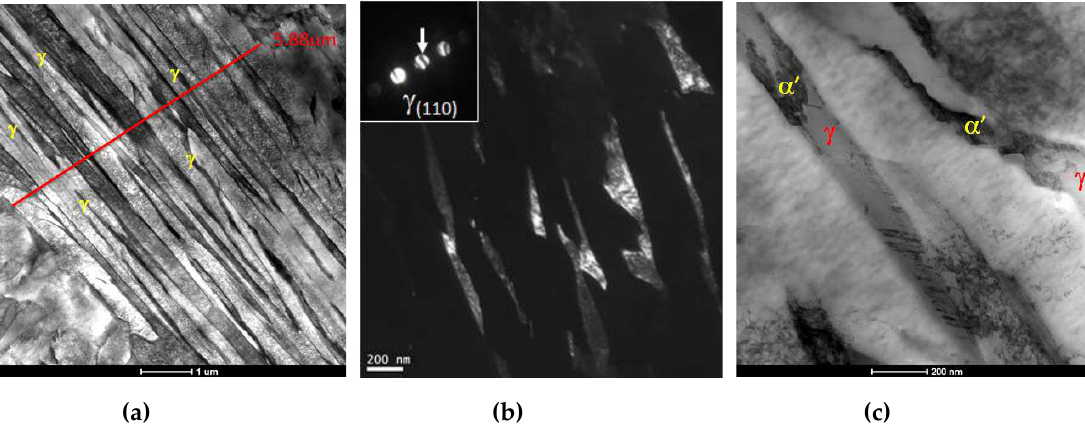
Figure 6. ( a ) Bright field STEM image of the Ref alloy transformed at 430 ◦ C; ( b ) dark field STEM image showing austenite films ( γ (110) reflection) from Ref + V transformed at 430 ◦ C and ( c ) bright field STEM image of Ref transformed at 430 ◦ C showing RA partially transformed to martensite.